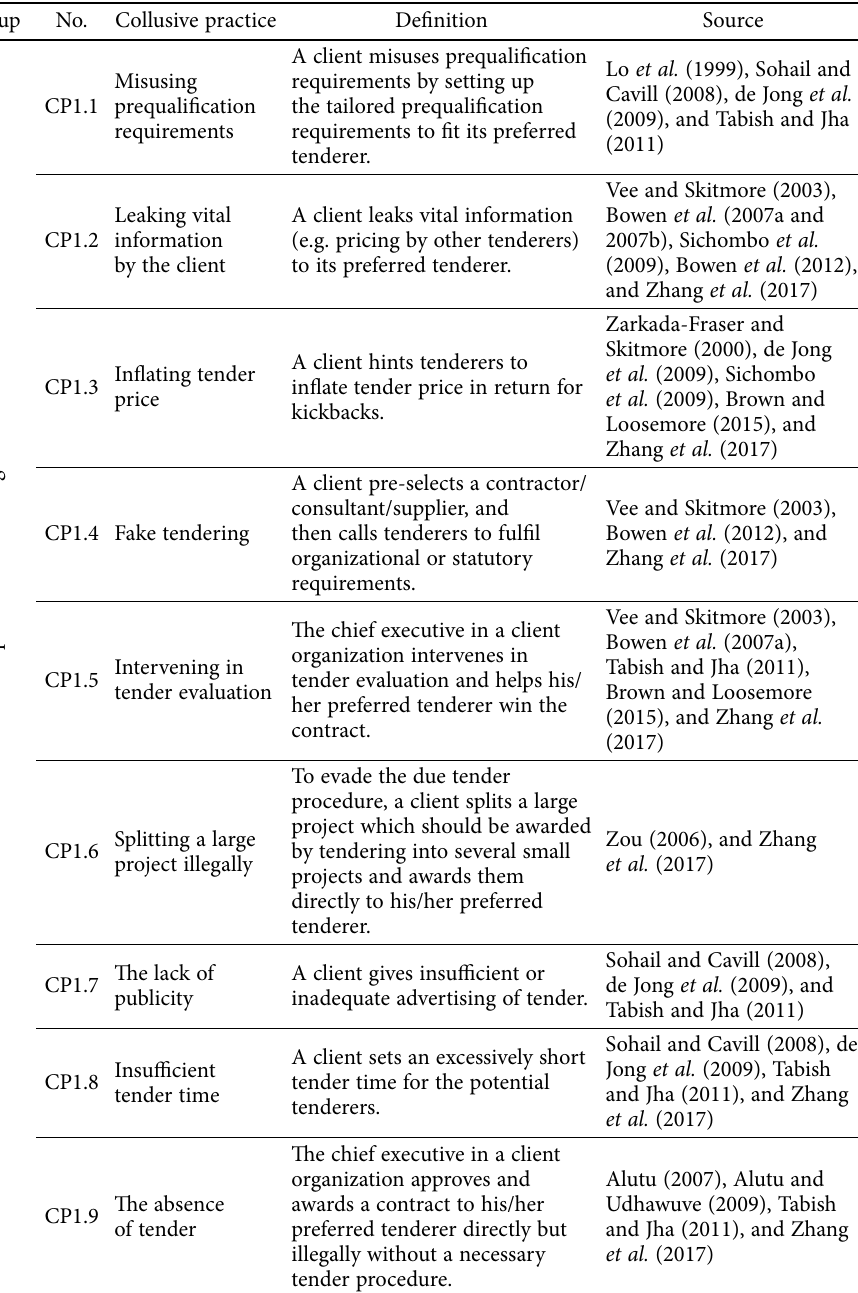
Table 2. Collusive practices spotted in existing